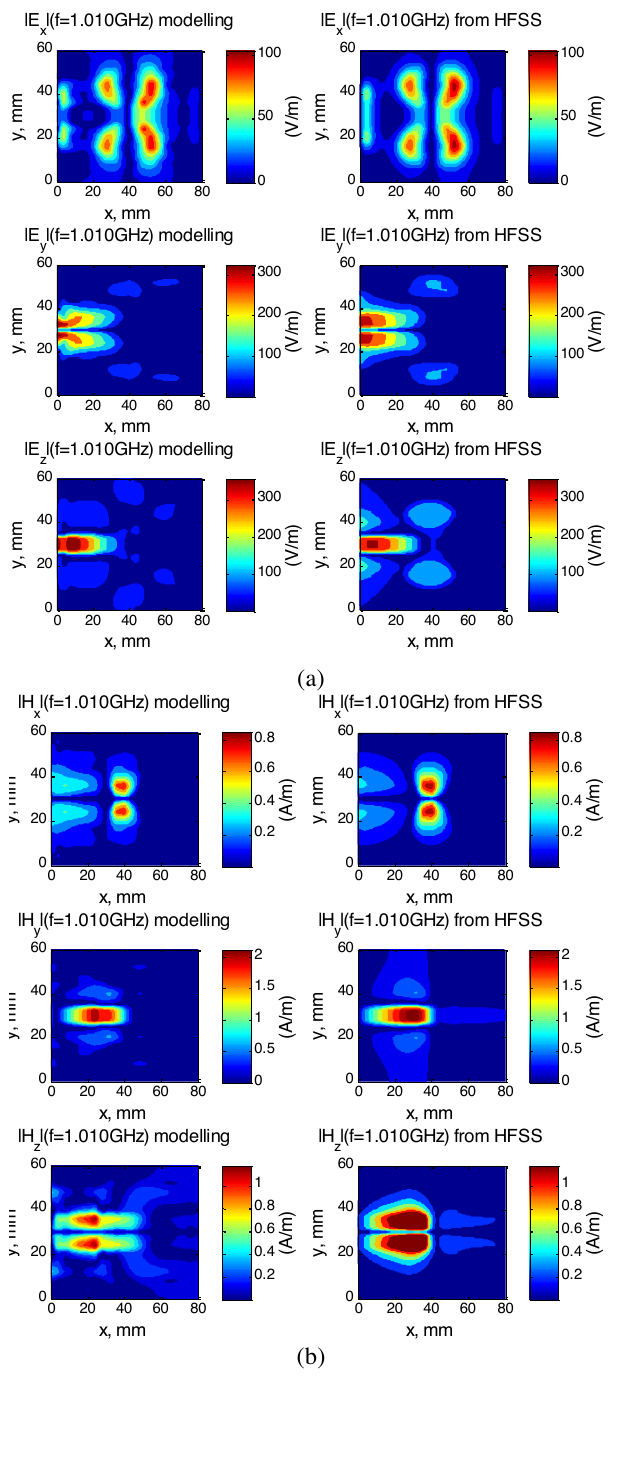
Figure 24: Device under study: planar microstrip filter.